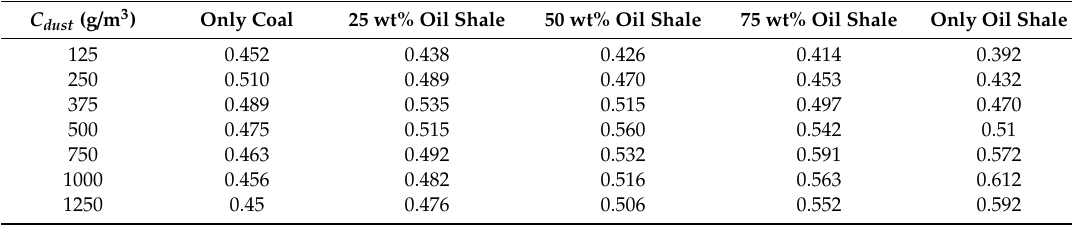
Table 3. The maximum explosion pressure ( P max ) (MPa) of mixed dust.